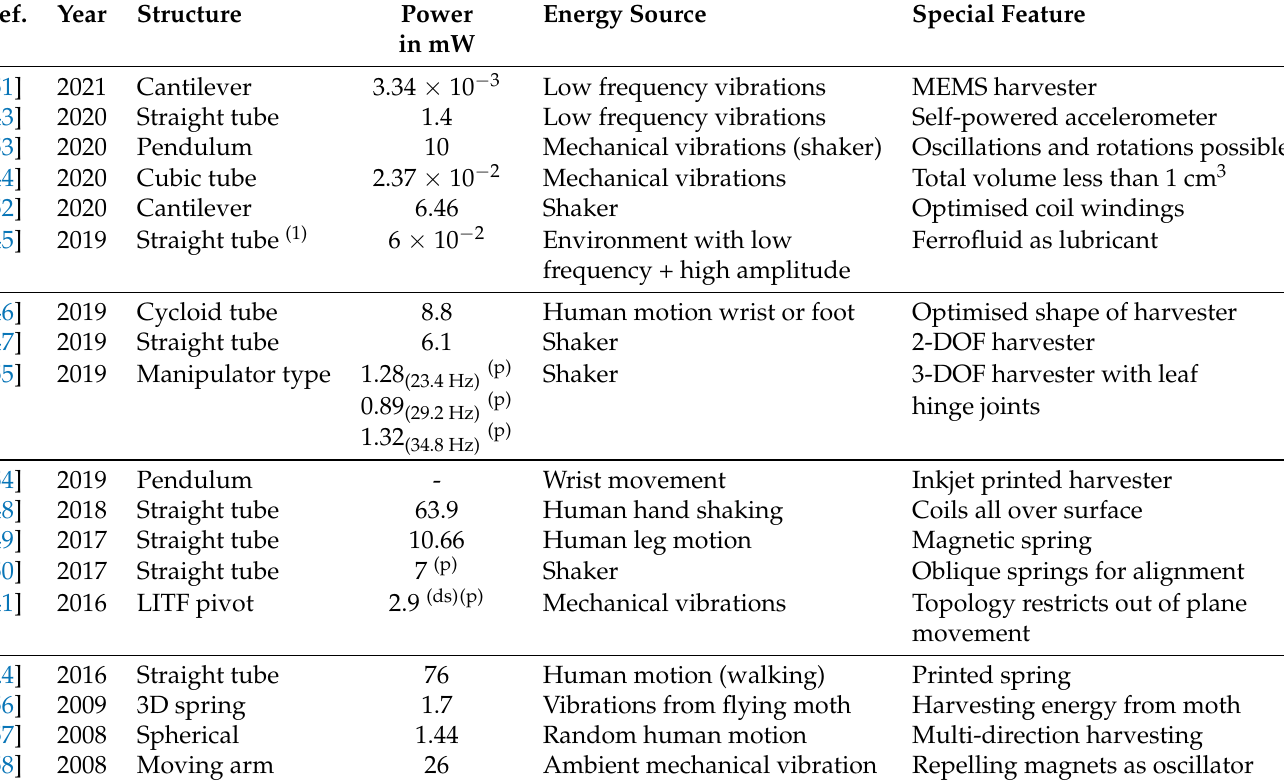
Table 2. 3D printed electromagnetic non-hybrid vibration harvesters in the literature.